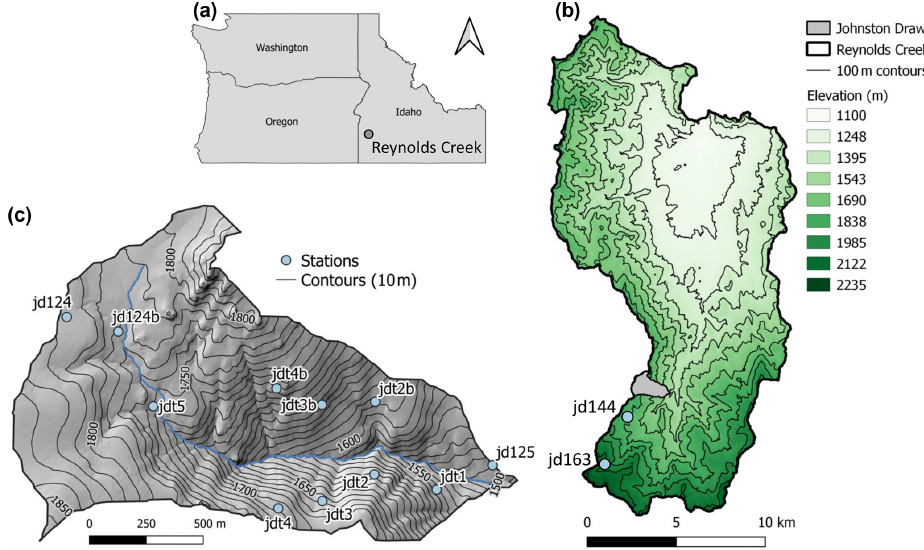
Figure 1. Maps of the location of (a) the Reynolds Creek Experimental Watershed (RCEW) in the state of Idaho (USA; EPSG:4269 – NAD83 projection); (b) the Reynolds Creek Experimental Watershed showing the elevation (white – lower and dark green – higher), the 100m contour lines, the location of Johnston Draw (gray polygon), and two additional precipitation gauges (light blue dots); and (c) Johnston Draw showing the weather stations (light blue dots), the stream (blue line), and the 10m contour lines (black lines) overlain on a hillshade digital elevation